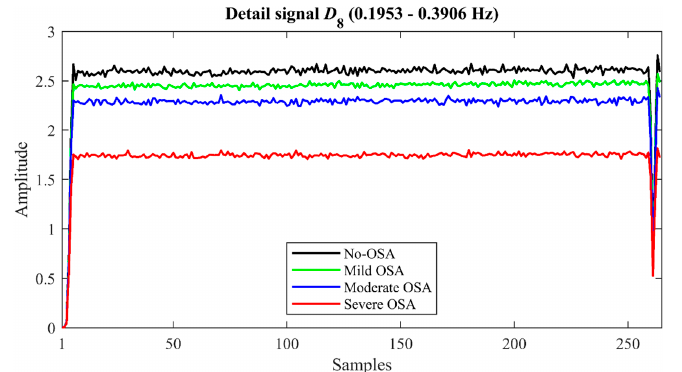
Figure 4. Averaged D 8 signal by OSA severity groups in the training group.